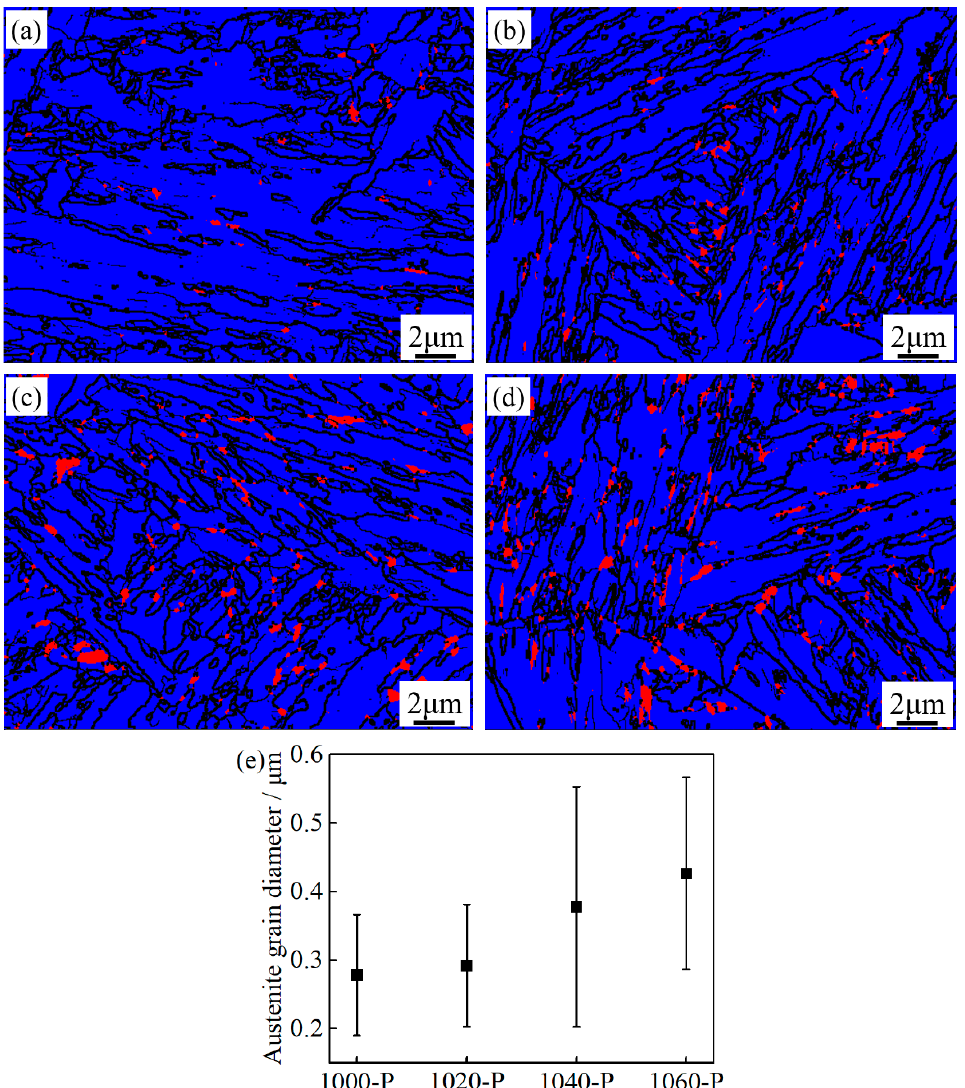
Figure 7. Combined phase map and grain boundaries of ( a ) 1000-P; ( b ) 1020-P; ( c ) 1040-P; and ( d ) 1060-P (red, blue and black represent the retained austenite, martensite and boundaries with misorientation >10 ◦ , respectively); ( e ) average equivalent circle diameter of the retained austenite (RA).